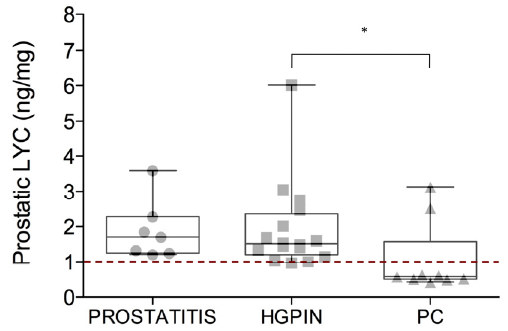
Figure 1. Box plots show group differences in prostatic lycopene concentration. Post hoc comparison analysis (Dunn’s test) showed a significant difference between HGPIN and PC groups. The red dotted line indicates the cut-off value of prostatic lycopene, which corresponds to the lowest quartile of the distribution (1 ng/mg). The line inside each box represents the median, the whiskers include the minimum and maximum of all of the data.